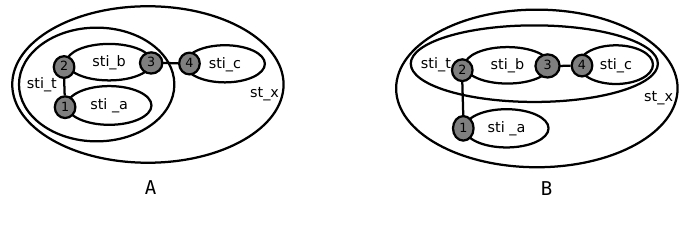
Figure 8: Different formats of the same